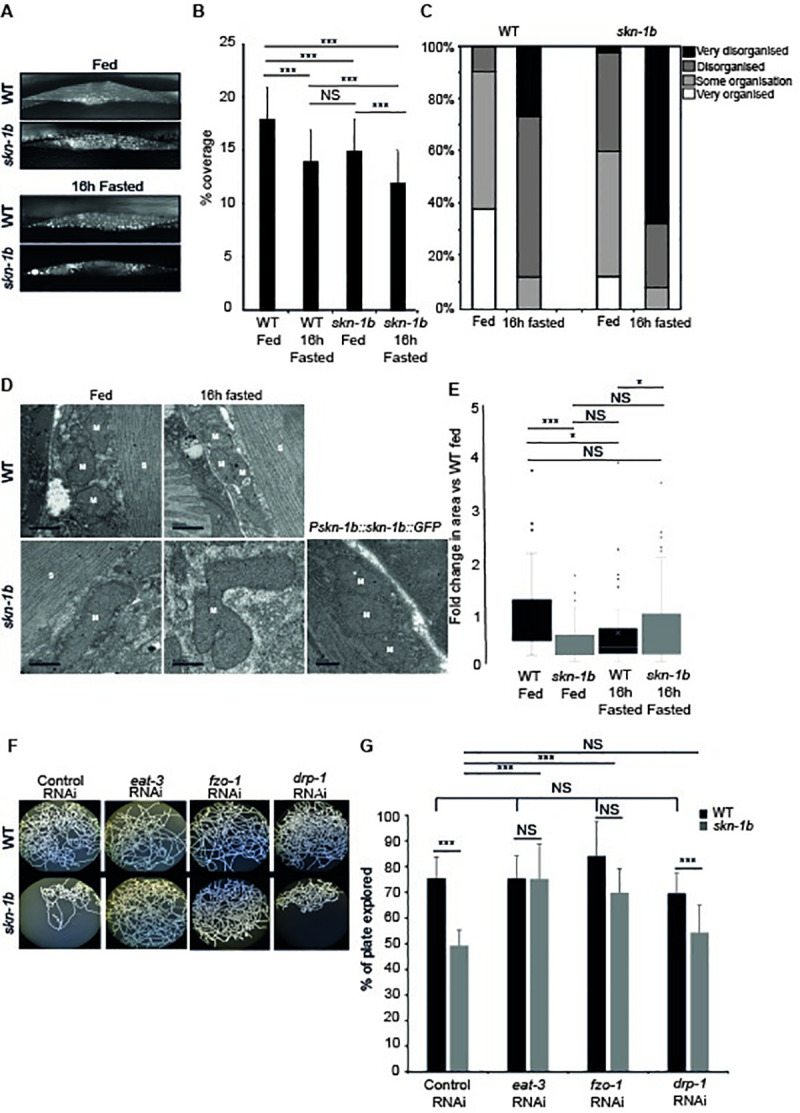
skn-1b contributes to mitochondrial network integrity.A-C) Expression and quantification of WT and skn-1b mutant worms expressing myo-3::GFP(mit). This muscle specific reporter expresses an outer mitochondrial membrane protein and hence marks all mitochondria, delineating their shape. In B and C) Each bar represents a mean of 3 biological replicates ± SEM, n>62 day 1 adults worms per group. The qualitative scoring system used in C) is shown in S12C Fig. D) Longitudinal sections imaged by Transmission Electron Microscopy (TEM). M = mitochondria, S = sarcomere. Scale bar = 500nm. E) Quantification of TEM: Mitochondrial area compared to WT control. Each bar represents a mean of 2 biological replicates, n>47 images per group ± SEM. F-G) Effect of mitochondrial fission and fusion on mitochondrial networks and behaviour in WT and skn-1b mutants. Controls for effectiveness of RNAi (S14A and S14B Fig). For all graphs: Two-tailed t-tests *p<0.05, **p< 0.001, ***p<0.0001, NS not significant.